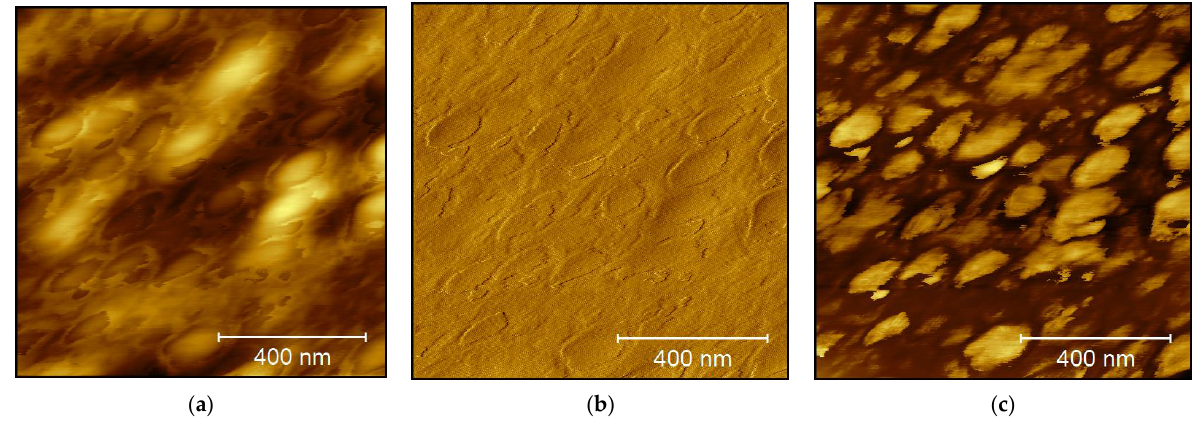
Figure 3. AFM images of a 3D printed acrylonitrile butadiene styrene (ABS) surface: ( a ) topography (height range 16 nm); ( b ) amplitude; ( c ) phase image (phase range 90°).